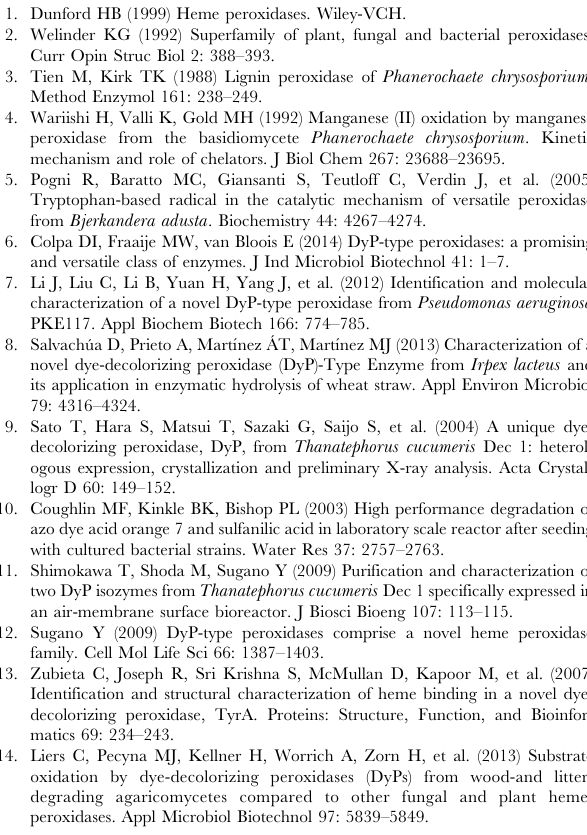
Figure S1 Model structure of Svi DyP. Model structure of SviDyP generated using template sequences from putative uncharacterized protein Sco3963 from Streptomyces coelicolor A3 (2) (PDB 4gt2A, GI: 541881521), whose amino acid sequence was 45.56% identical to SviDyP. The a -helices are shown in red and the b -sheets in yellow. Figure S2 Paper properties of Svi DyP and chemically- treated eucalyptus kraft pulp. a . paper brightness on various enzyme dosages. b . paper kappa number on various enzyme dosages. c . paper brightness on various time intervals. d . paper kappa number on various time intervals.